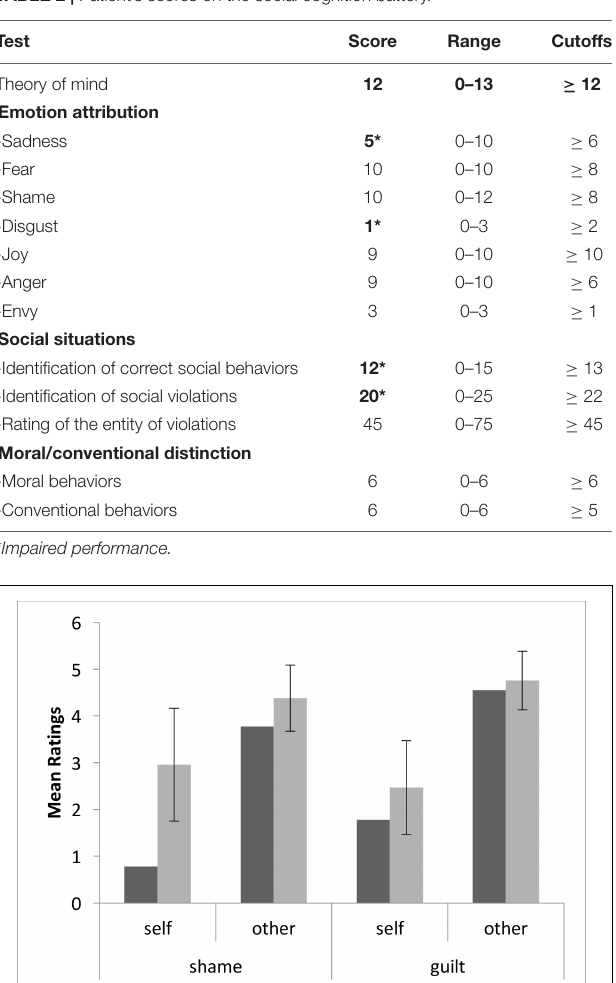
TABLE 2 | Patient’s scores on the social cognition battery.